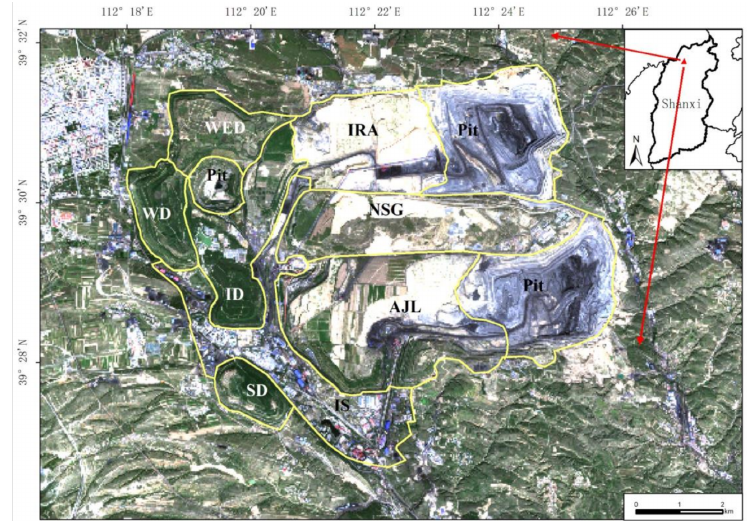
Figure 1. Location of the study area. SD, WD, WDE, and ID are, respectively, the abbreviations for the south dump, the west dump, the west expansion dump, and the inner dump of the Antaibao mine. IRA, NSG, AJL, and IS are abbreviations for the initial reclamation area of the inner dump, Nansigou, Anjialing mine, and industrial sites, respectively. The remote sensing image was from Sentinel-2 remote sensing data, 17 September